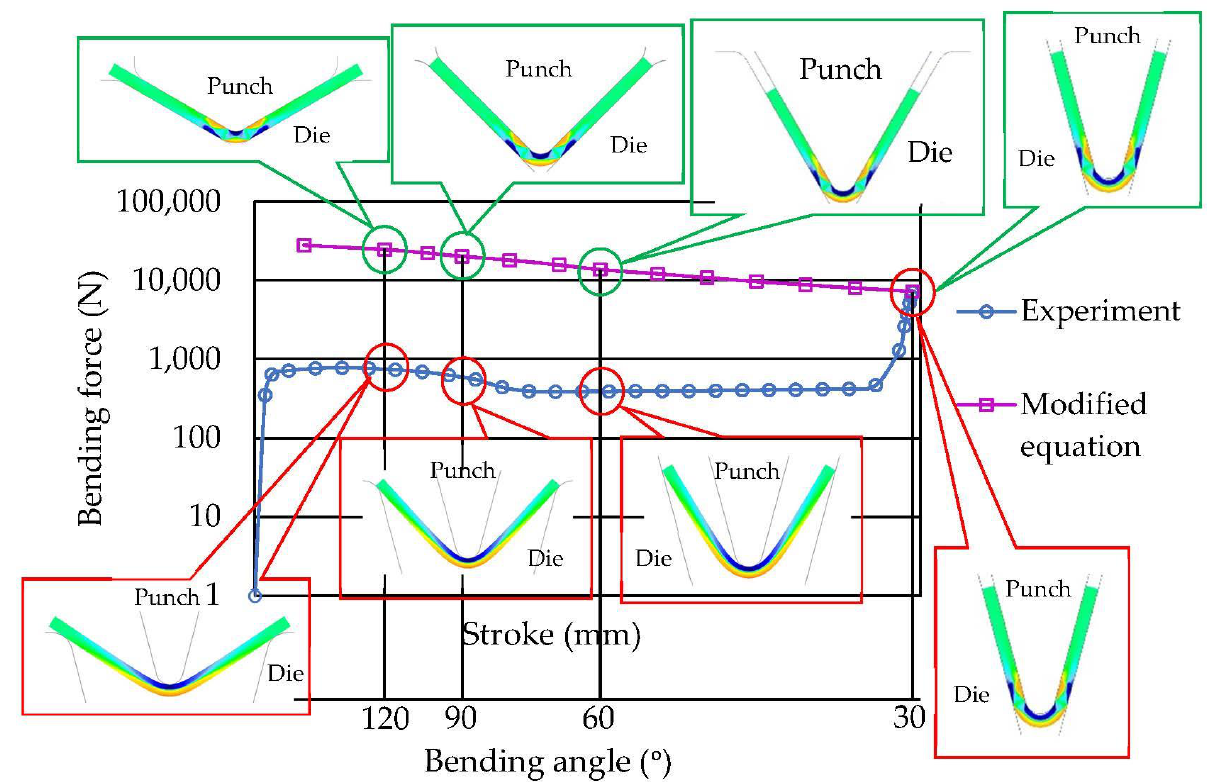
Figure 14. Comparison of the bending force calculated by the modified V-die bending force formula and obtained by FEM simulation during the bending process and at the complete bending stage.